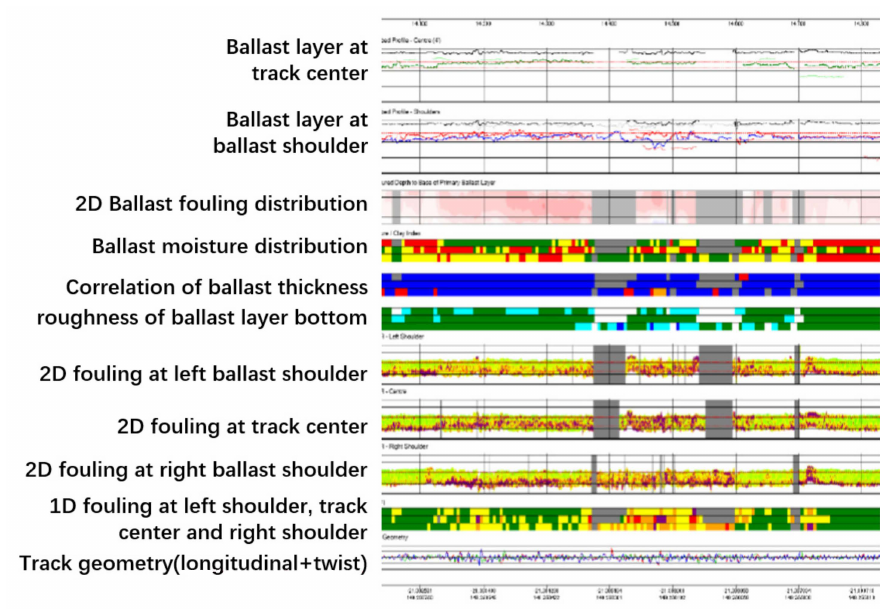
Figure 19. Integration of track and ballast layer indicators (figure reproduced from [87]).